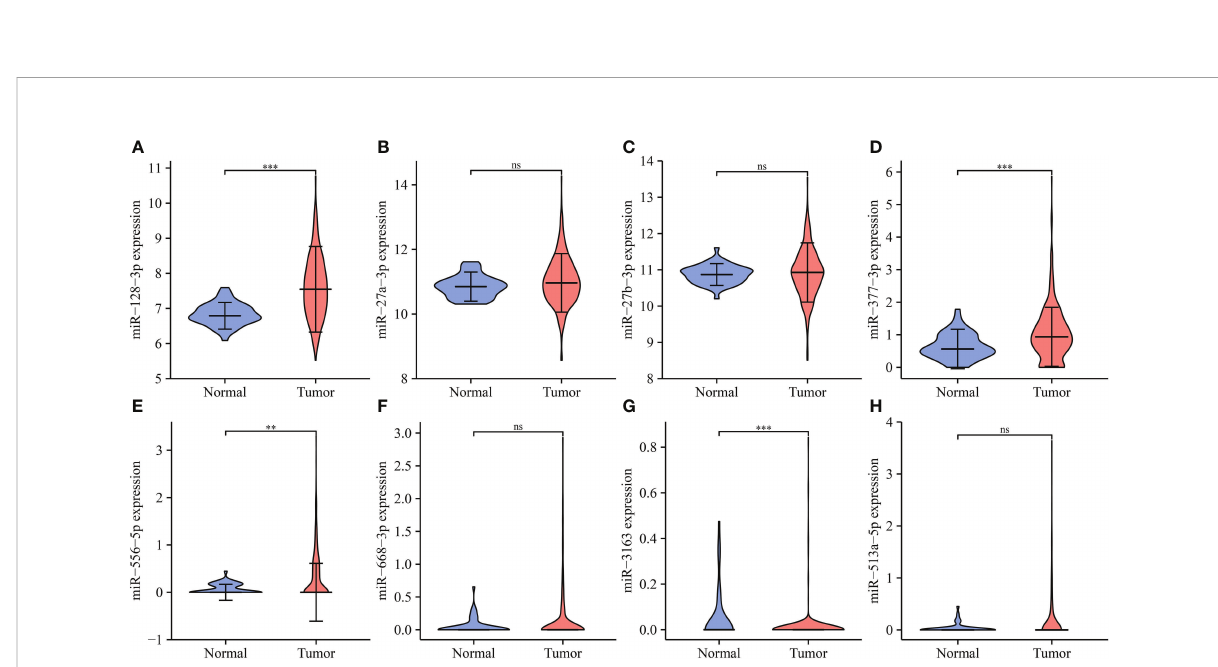
FIGURE 10 The expression levels of IL18R1-related miRNAs in LUSC. (A) miR-128-3p; (B) miR-27a-3p; (C) miR-27b-3p; (D) miR-377-3p; (E) miR-556-5p; (F) miR- 668-3p; (G) miR-3163; (H) miR-513a-5p. LUSC, lung squamous cell carcinoma; **P < 0.01; ***P < 0.001; ns, no statistical signi fi